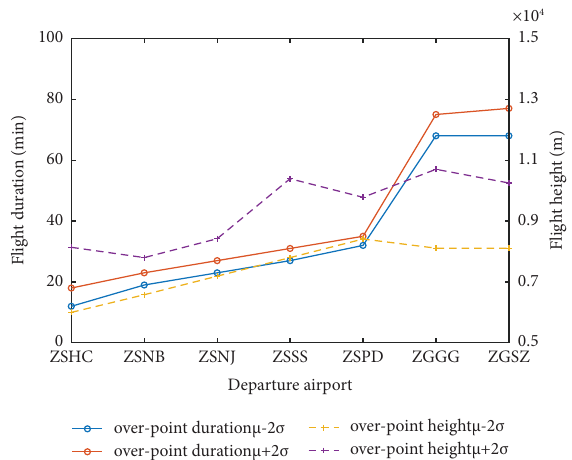
Figure 11: Over ELNEX waypoint fight length fight altitude.